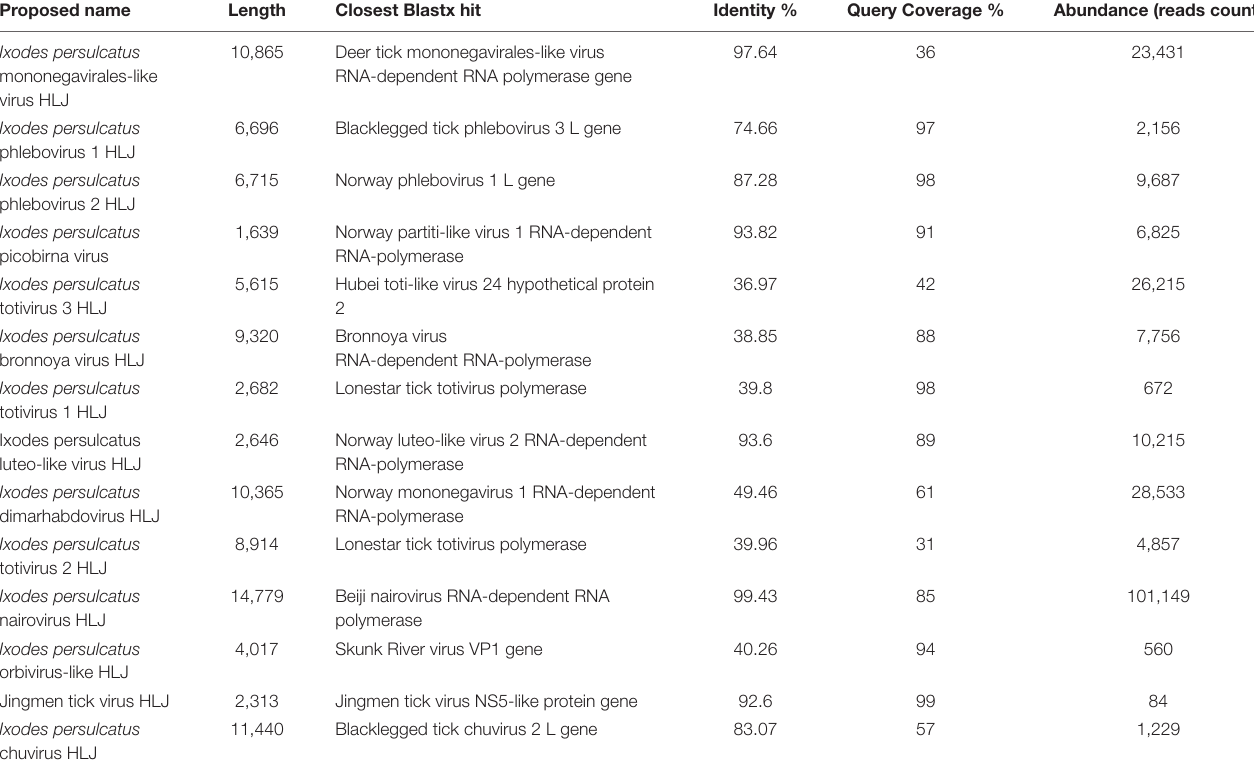
TABLE 1 | Summary of the viruses discovered by RNAseq in Ixodes persulcatus ticks removed from human patients at Mudanjiang Forestry Central Hospital in Heilongjiang Province,